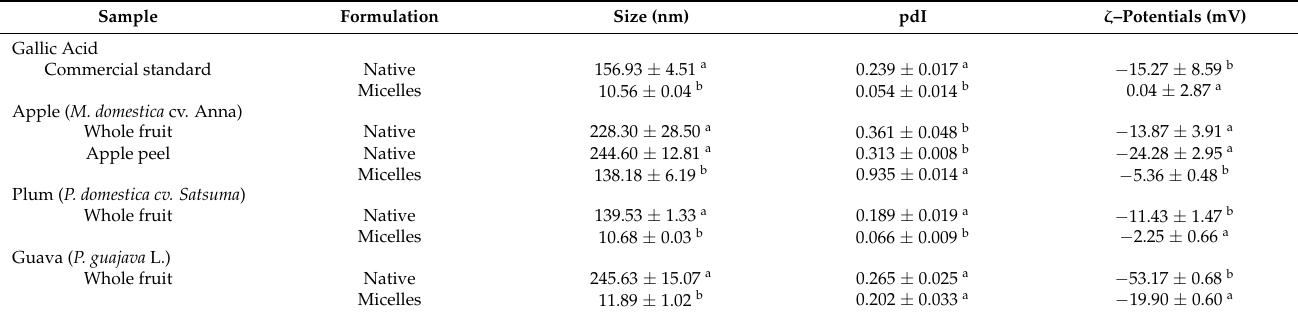
Table 3. Particle size, polydispersity index (pdI), and ζ -potential ( n = 6) of apple ( M. domestica cv. Anna), plum ( P. domestica cv. Satsuma), and guava ( P. guajava L.) fruit extracts as native powder and their micellarized formulations.